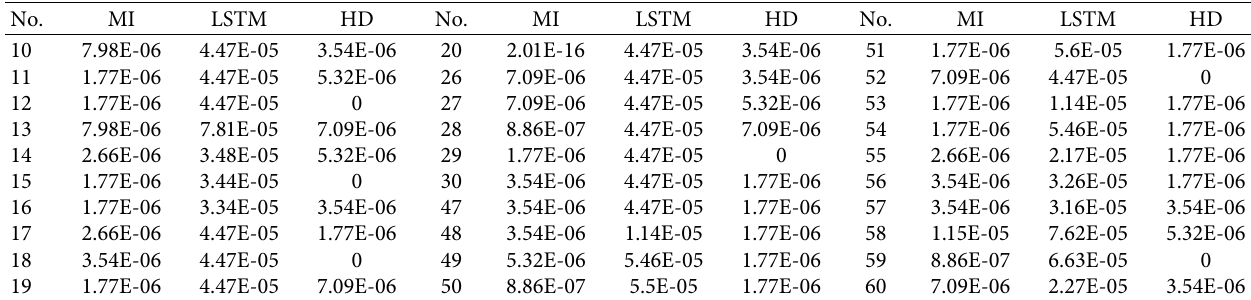
Table 1: Comparison of the filling error rates for missing data in outlet temperature of the first loop. No.